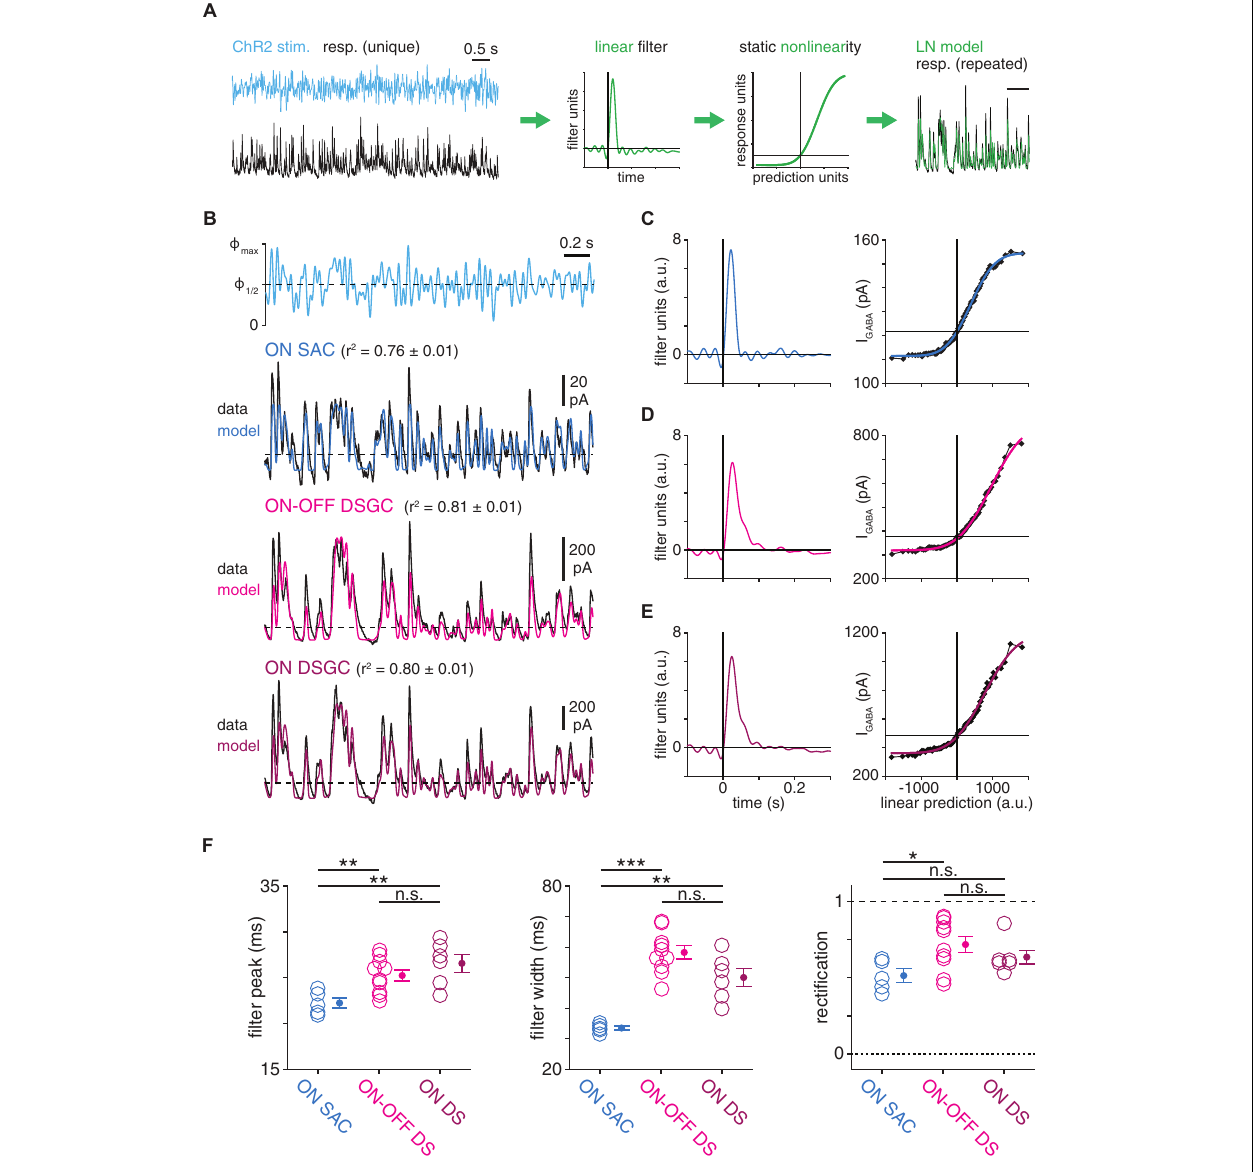
FIGURE 2 | Computational properties of GABAergic SAC synapses differ with postsynaptic cell type identity. (A) Schematic illustrating generation of a linear-nonlinear (LN) model from a response evoked by white-noise (WN) ChR2 stimulation (see “Materials and Methods section”). (B) Linear-nonlinear models obtained from IPSCs recorded in ON SACs and DSGCs during optogenetic white-noise stimulation of SACs. Black traces indicate averaged response to 10 stimulus repeats [maximum stimulus intensity ( (cid:56) max ) = 4.8 × 10 17 Q cm– − 2 s − 1 ). Colored traces show LN model output. Dashed horizontal lines indicate the response at a linear prediction of 0 (see C–E ). (C–E) , Linear filter ( left ) and static nonlinearity ( right ) obtained from ON SAC (C) , ON-OFF DSGC (D) , and ON DSGC (E) in (B) . Horizontal line overlaid on each static nonlinearity indicates the response at a linear prediction of 0. (F) Measurements of LN model components obtained from IPSCs recorded in ON SACs ( n = 5), ON-OFF DSGCs ( n = 10), and ON DSGCs ( n = 6). The ON-OFF DSGC shown in (B,D) and data from DSGCs in (F) are re-plotted from Pottackal et al. (2020). n.s., not significant; * p < 0.05; ** p < 0.01; and *** p <